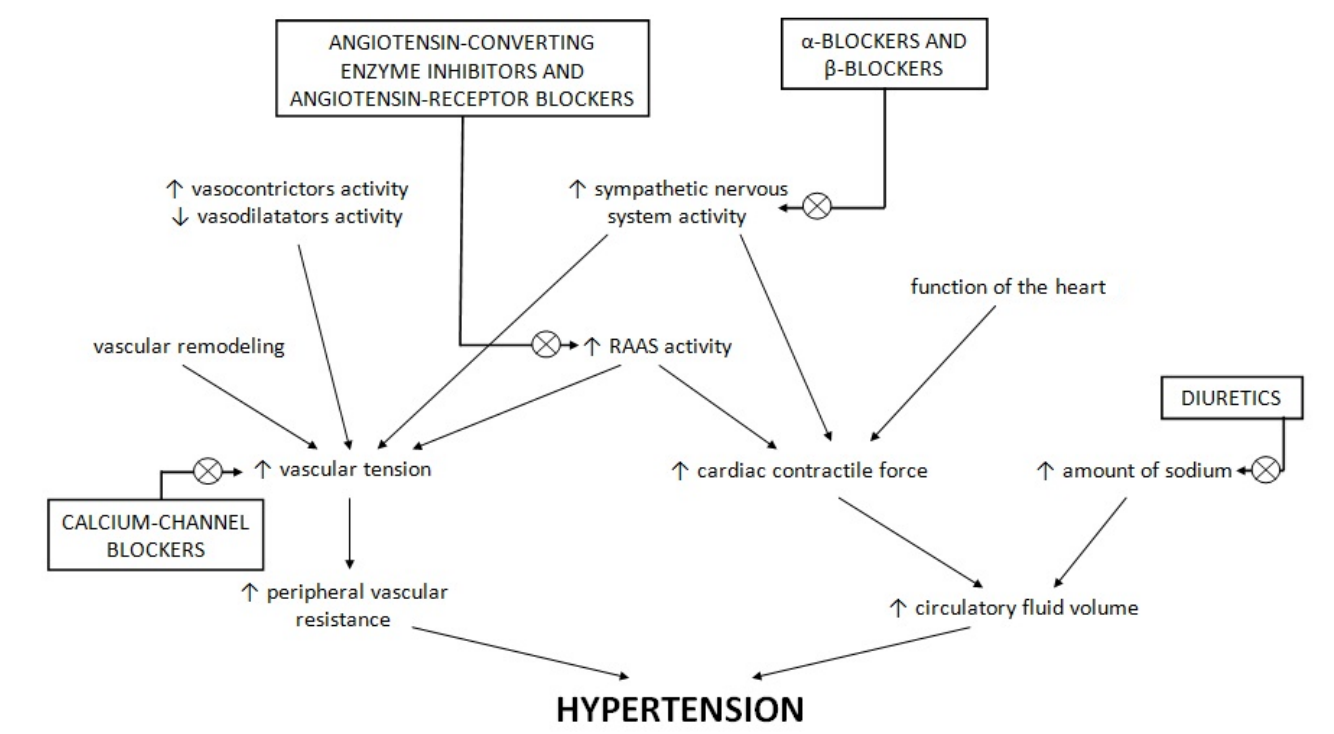
Figure 1. The pathogenesis of hypertension and targets for typical hypotensive drugs.